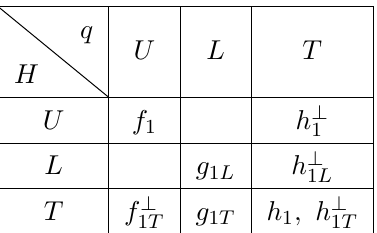
Table 1 . TMDPDFs for quarks. We have quark polarizations in the row with U = unpolarized, L = longitudinal polarized, and T = transversely polarized quarks. On the other hand, the column represents polarization of the hadron H (i.e. the proton in our